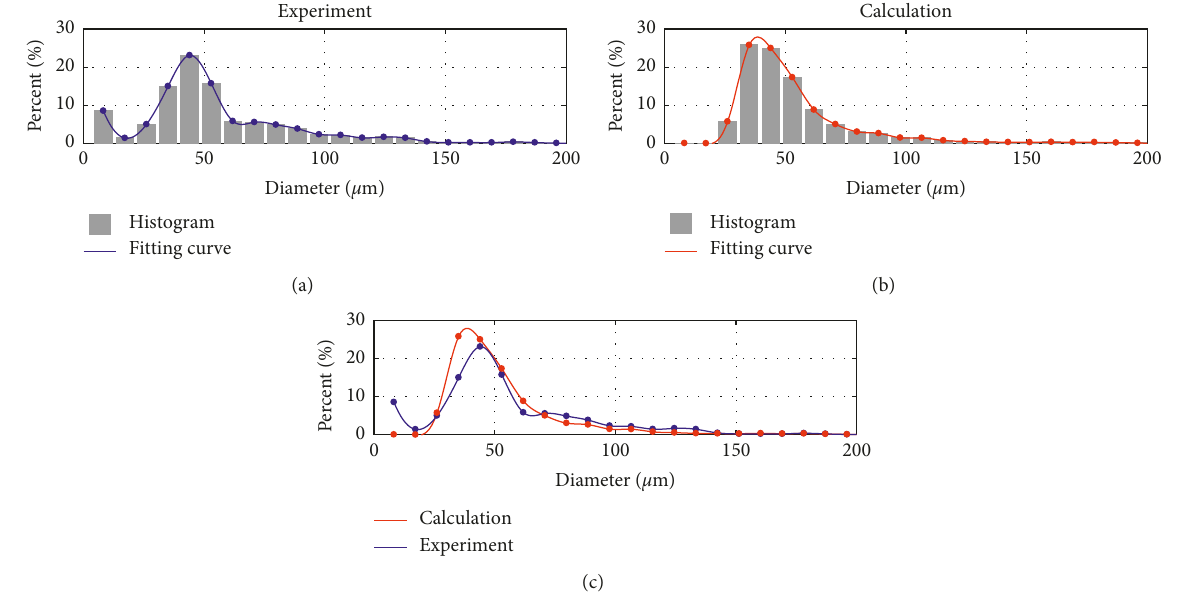
Figure 9: Droplet size distribution. (a) Histogram of experimental drop size distribution, (b) histogram of calculated drop size distribution, and (c) comparison of experimental data with calculated results.